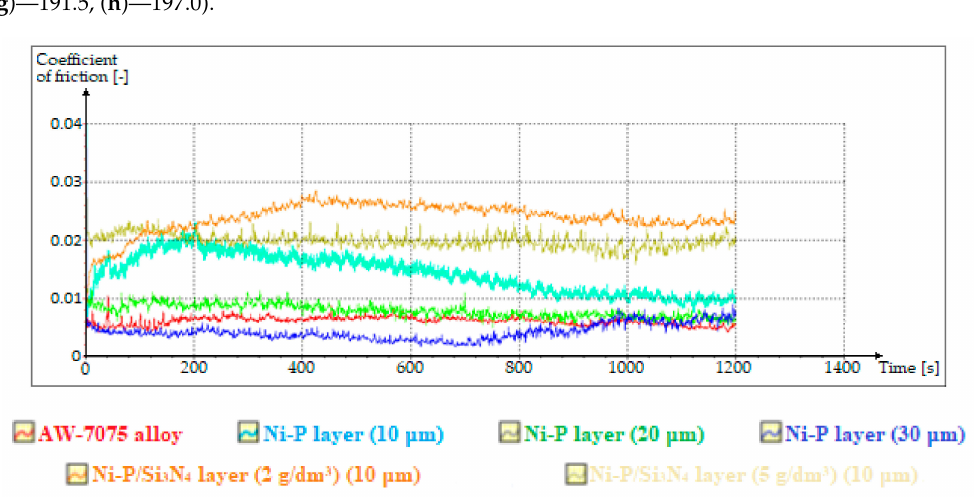
Figure 10. Graph of friction coe ffi cient changes during tribological